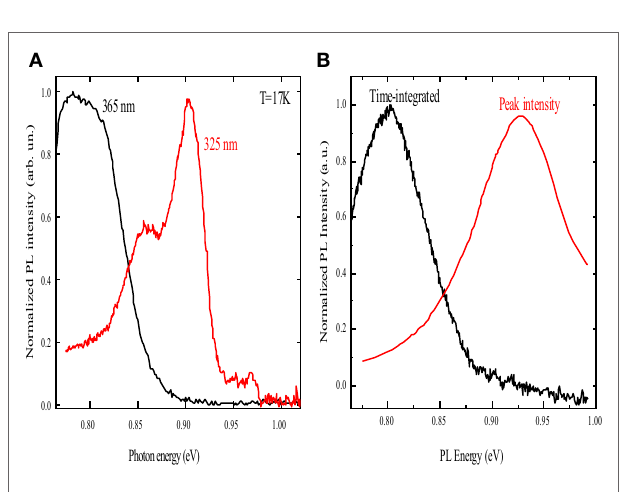
FiGURe 15 | Low-temperature (17 K) PL spectra recorded under (A) Cw excitation with the indicated excitation wavelengths and (B) pulsed 355-nm excitation using the time-integrated and peak- intensity methods (Mala et al., 2014)